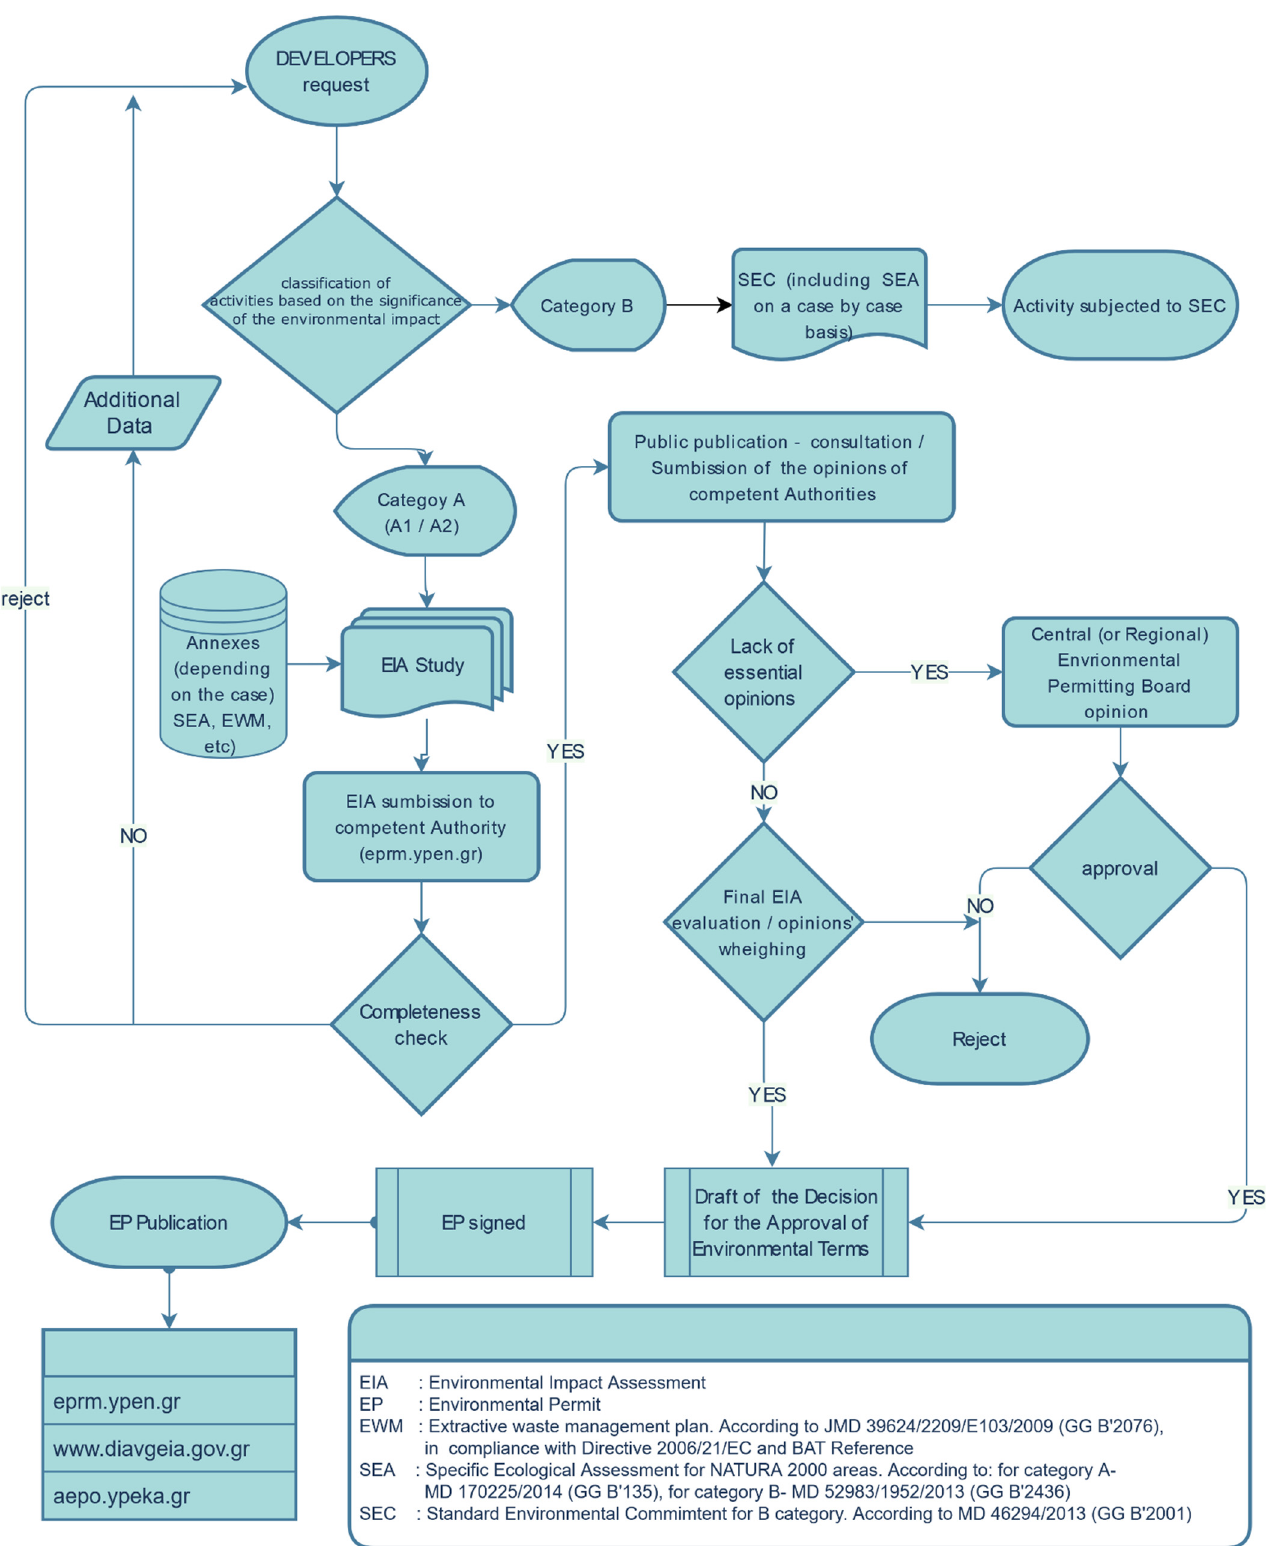
Figure 6. Environmental permitting procedure flowchart according to L.4014/2011 (as amended by L.4685/2020). Institutional Review Board Statement: Not applicable.